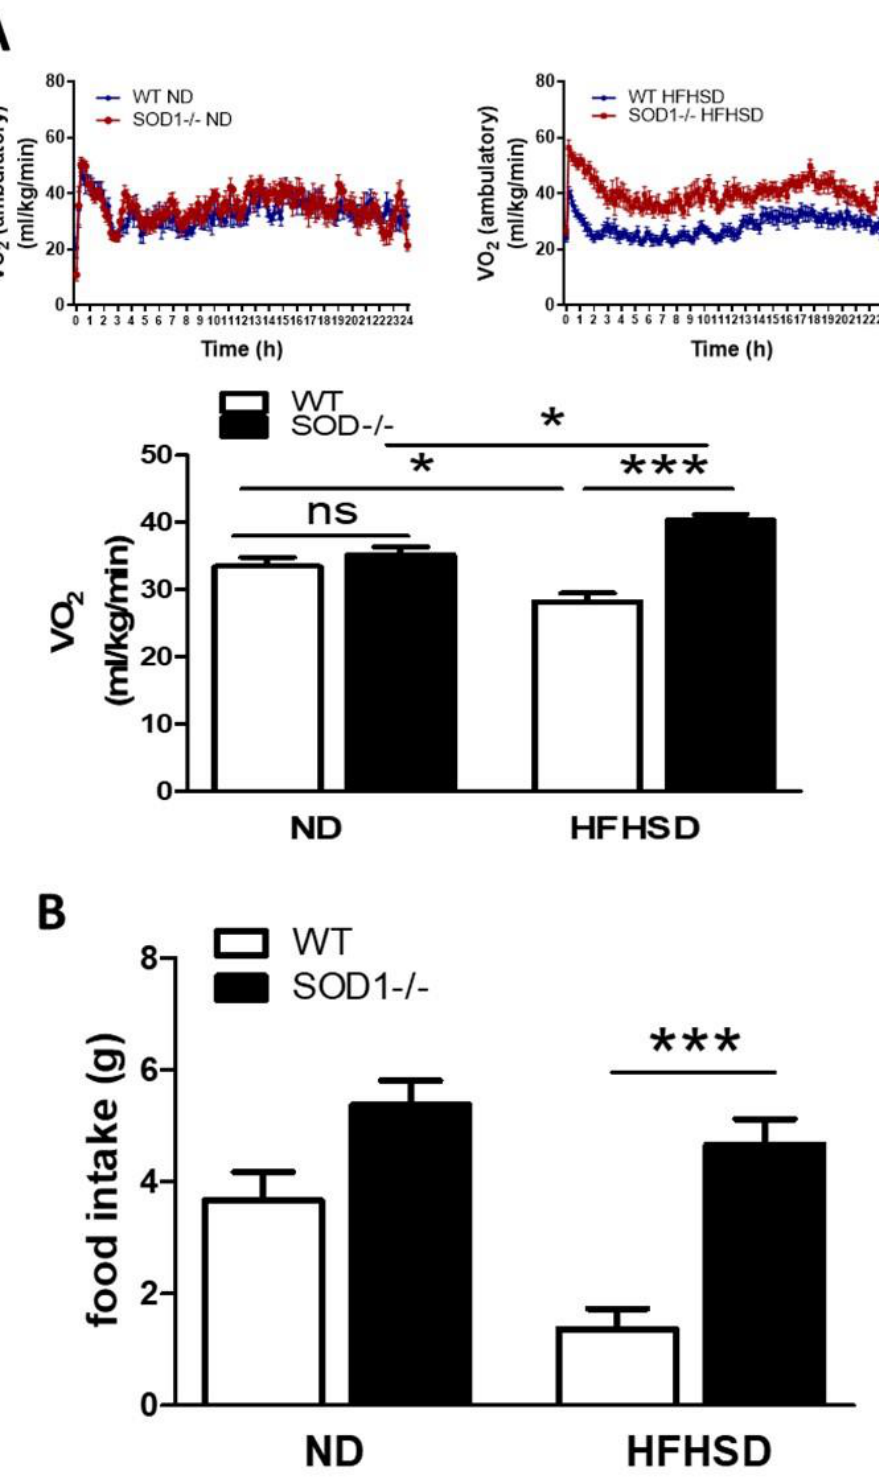
Figure 4. Oxygen Consumption and Intake of the Diet. ( A ). The oxygen consumption in ambulatory condition for 24 h and the quantitative analysis of averages oxygen consumption. (WT on ND; n = 7, SOD1 − / − on ND; n = 7, WT on HFHSD; n = 6, SOD1 − / − on HFHSD; n = 9). ( B ). Quantitative analysis of dietary intake. Error bars represent SEM. * p < 0.05, *** p < 0.001. WT: wild-type mice, SOD1 − / − : SOD1 deficient mice, ND: normal diet, HFHSD: high-fat/high-sucrose diet.